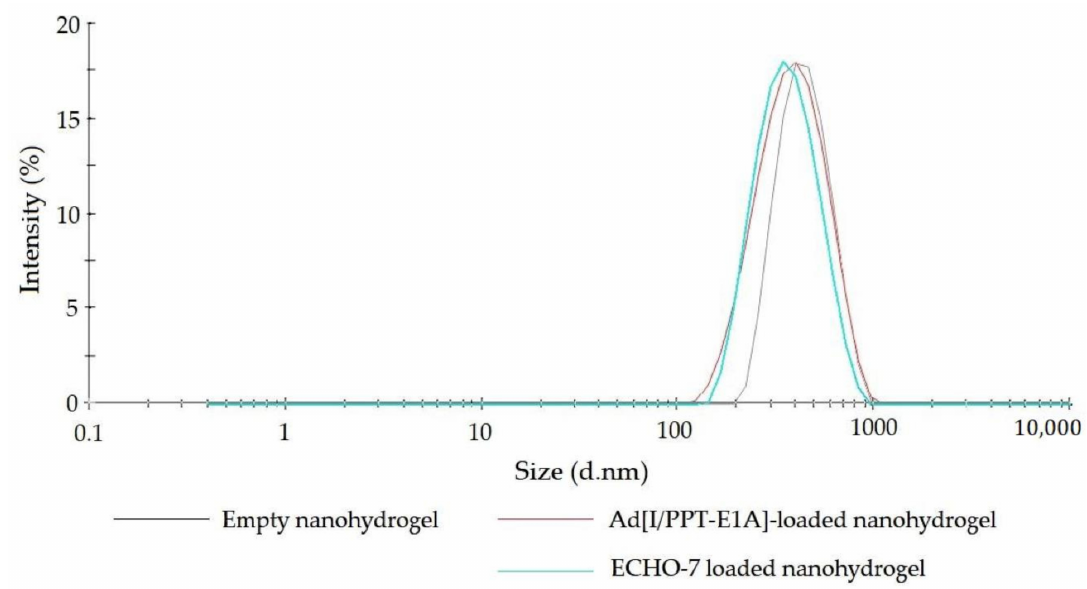
Figure 4. Size distribution curve of developed nanohydrogels examined by